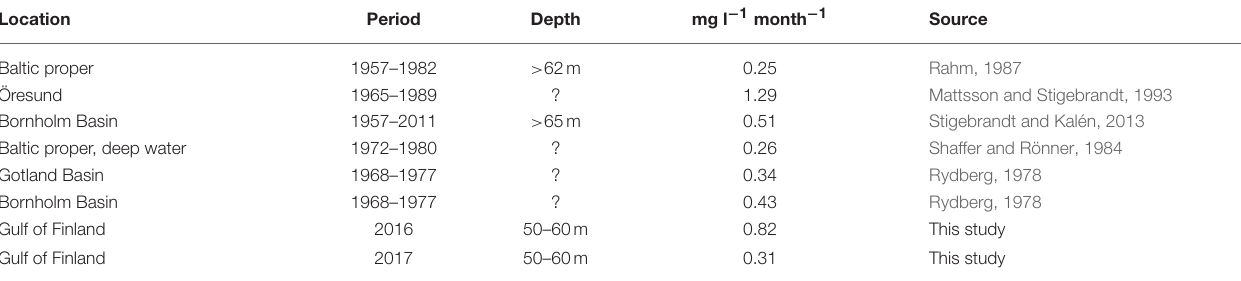
TABLE 4 | Monthly average oxygen consumption results found in the literature.